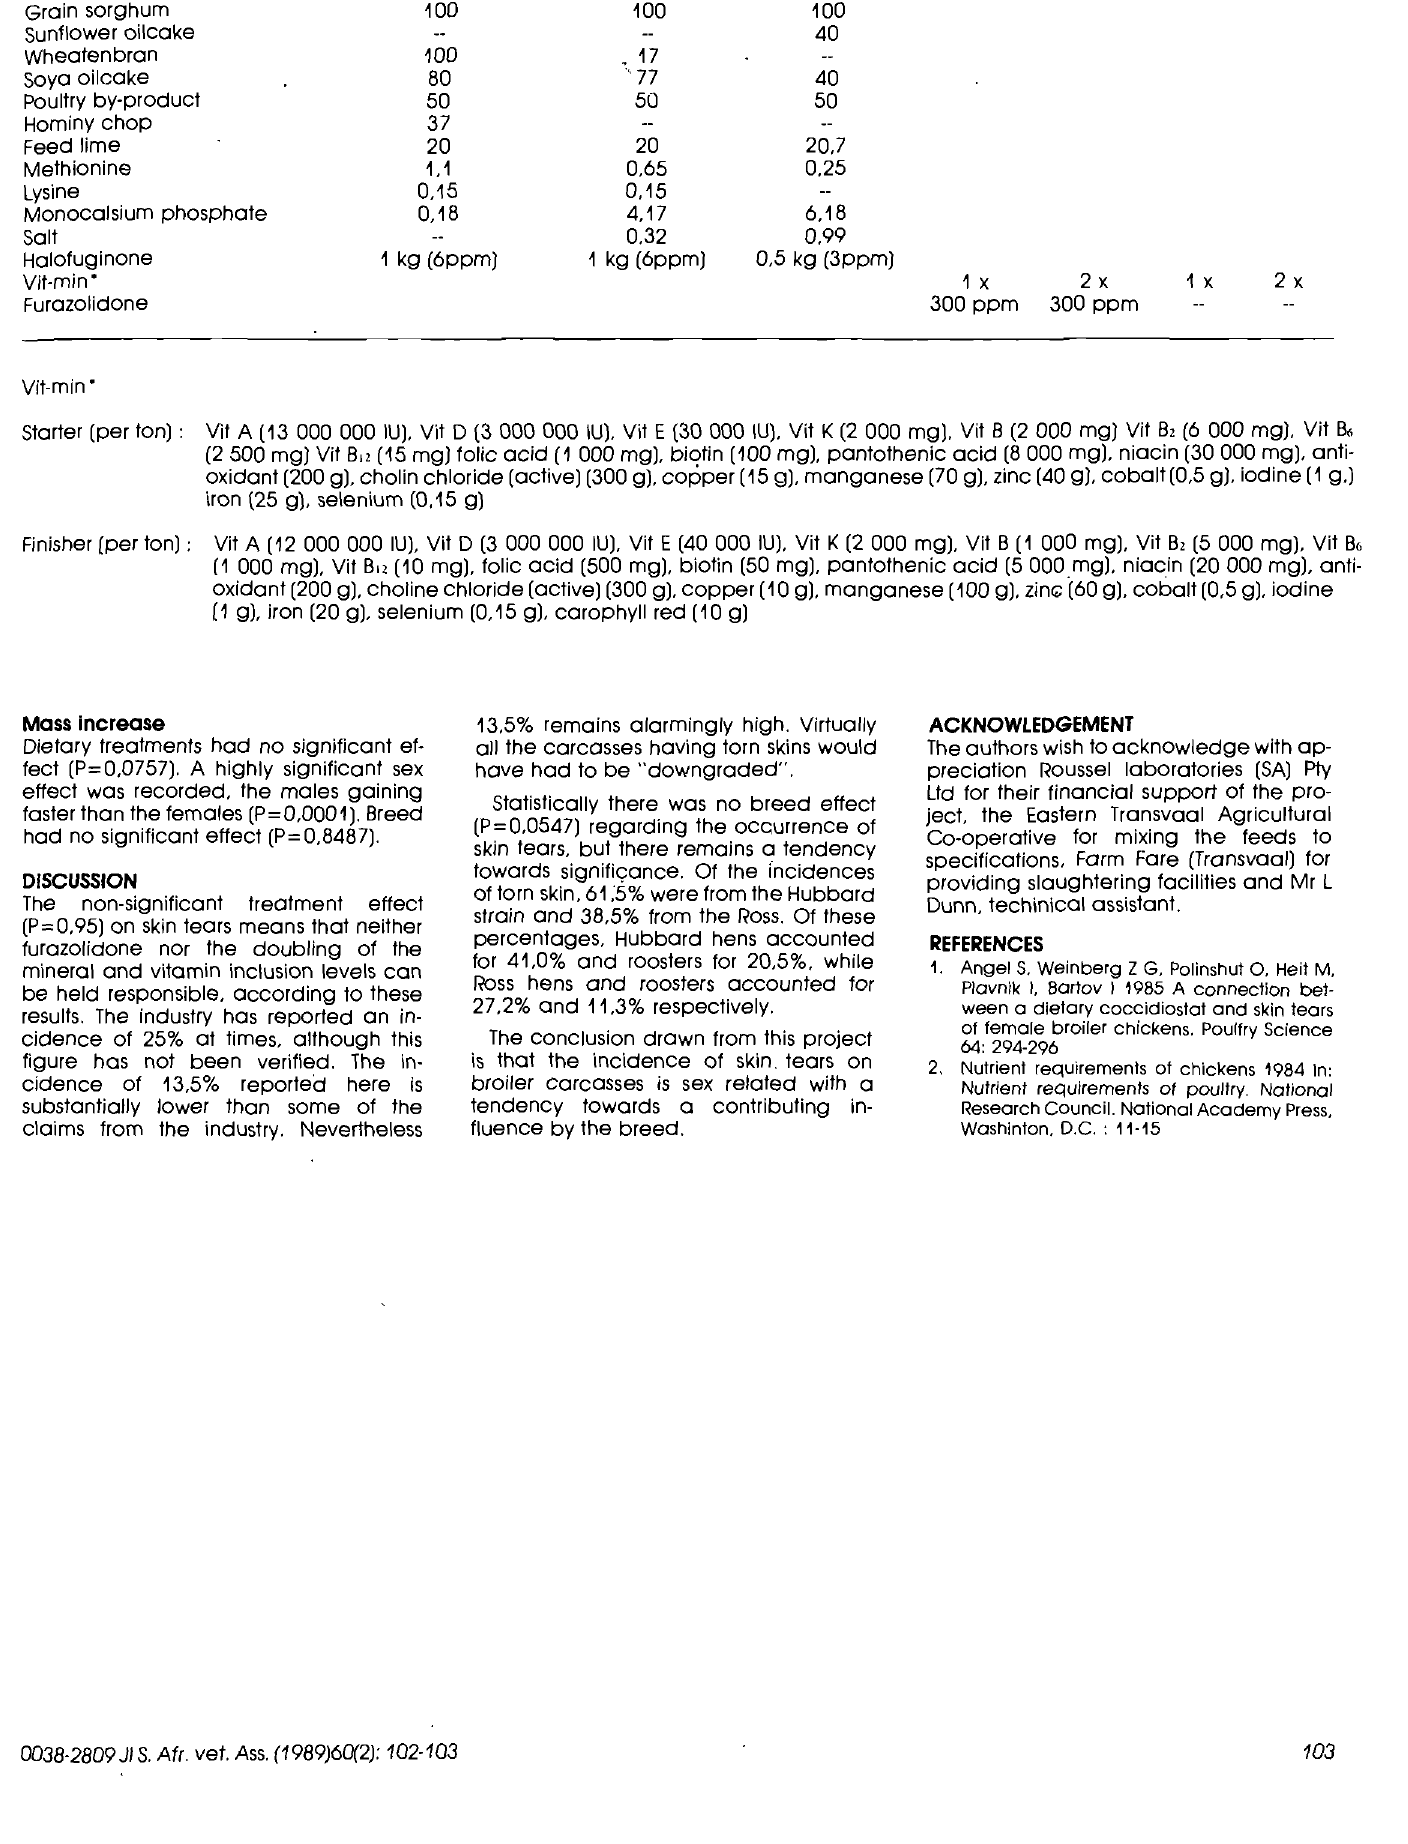
Table 1: Dietary treatments given to groups of experimental broiler strains Dietary components (kg/tl Starter Grower Yellow